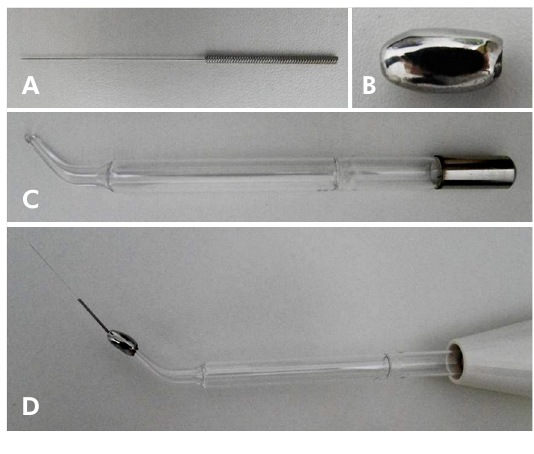
Figure 1. Adapter at the “Oto” tip of the OZY ® system: (A) “endodontic” tip, (B) adapter, (C) “Oto” tip and (D) mounted OZ ®